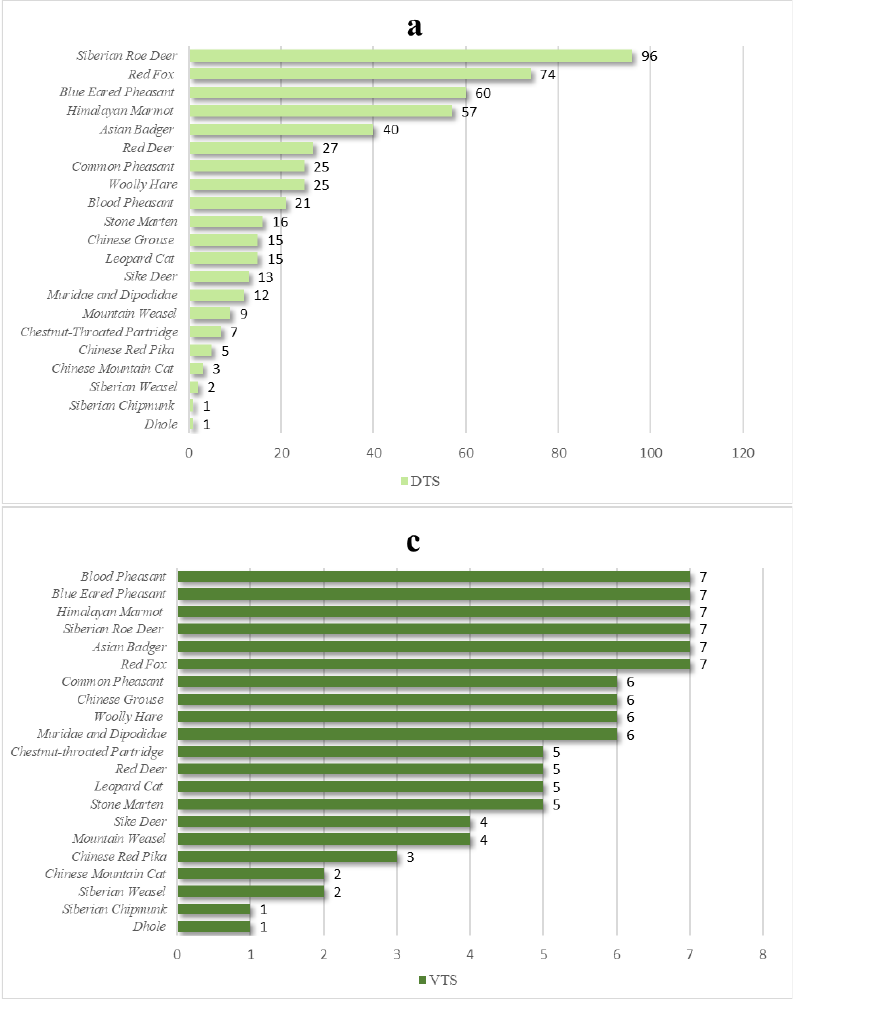
Figure 2. ( a ). The number of detected traps of species (DTS); ( b ) Distribution of elevation range (ER)/elevation difference (ED) of species (the red numbers indicate elevation difference); ( c ) Distribution of vegetation types of species (VTS); ( d ) The Number of independent detections of species (IDS).